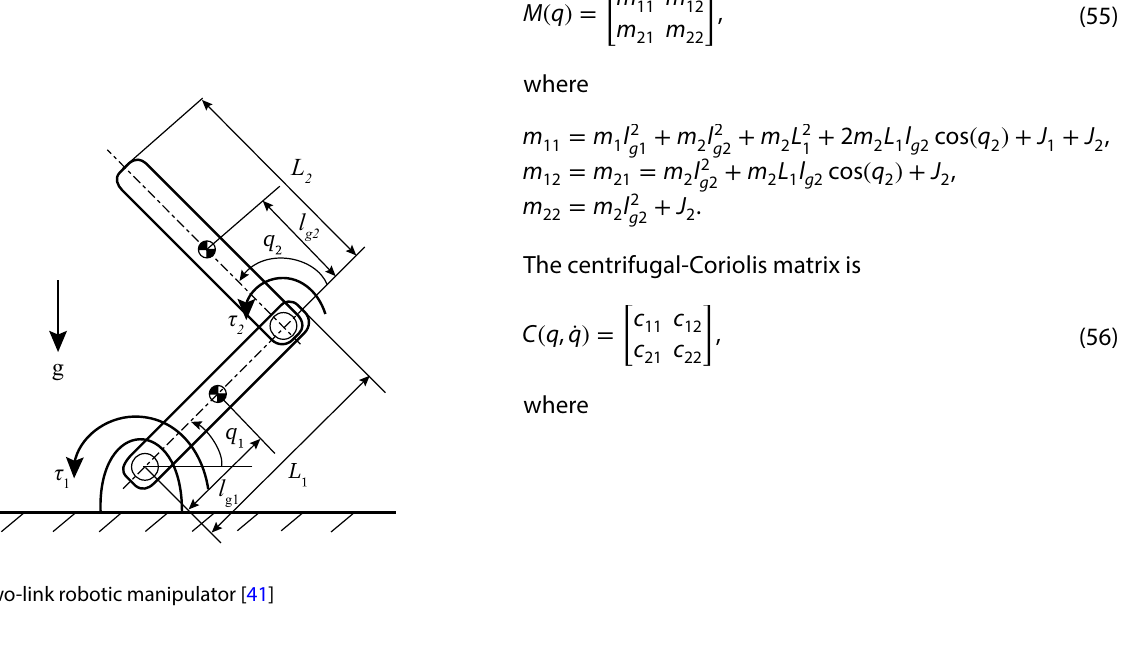
Table 2 Physical parameters for two-link robotic manipulator